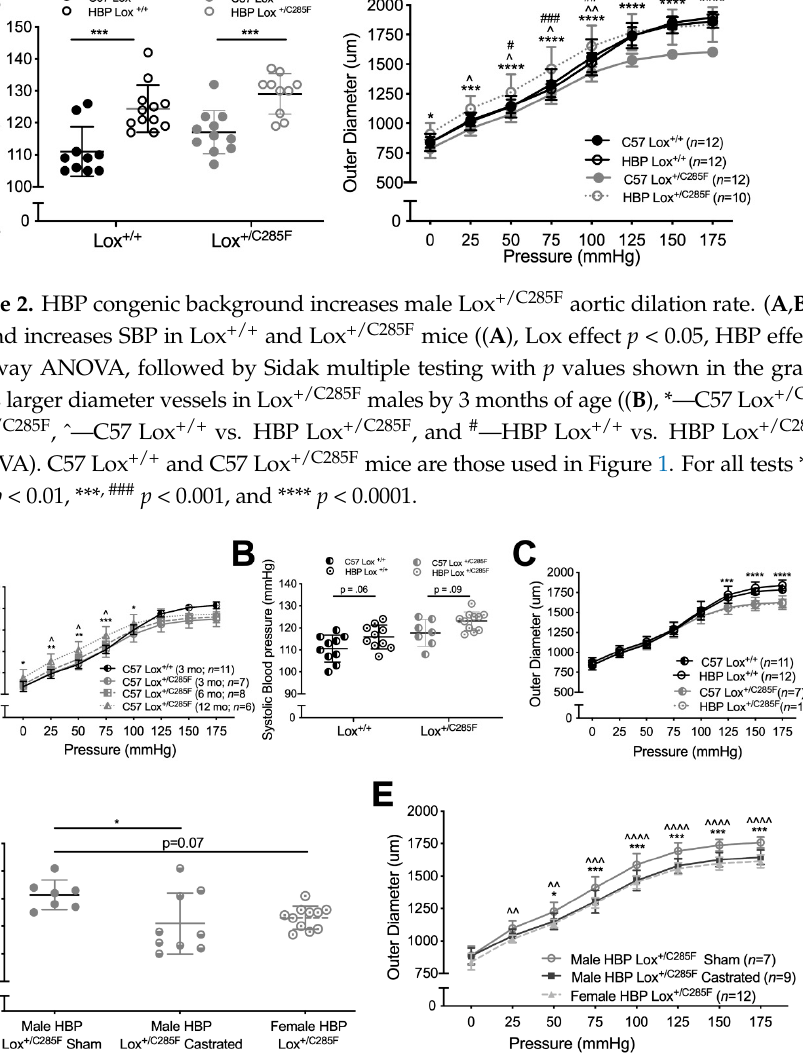
Figure 2. HBP congenic background increases male Lox +/C285F aortic dilation rate. ( A , B ), HBP back- ground increases SBP in Lox +/+ and Lox +/C285F mice (( A ), Lox effect p < 0.05, HBP effect p < 0.0001, two-